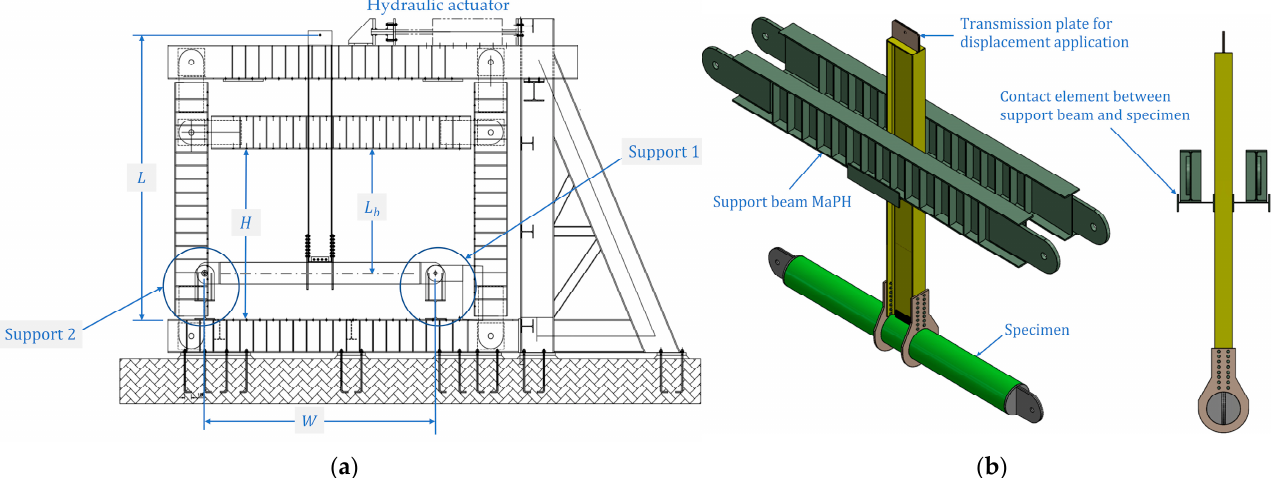
Figure 3. Experimental setup, including the mounting details of the beam-column connection: ( a ) Two supports were installed at each end of the column having the following constrain conditions: at end 1, translations in the plane and out of the plane were restricted; at end 2, vertical translation and translation outside the plane were also restricted; rotation in the plane was allowed for both ends; and ( b ) beams that provide lateral support to the framework.